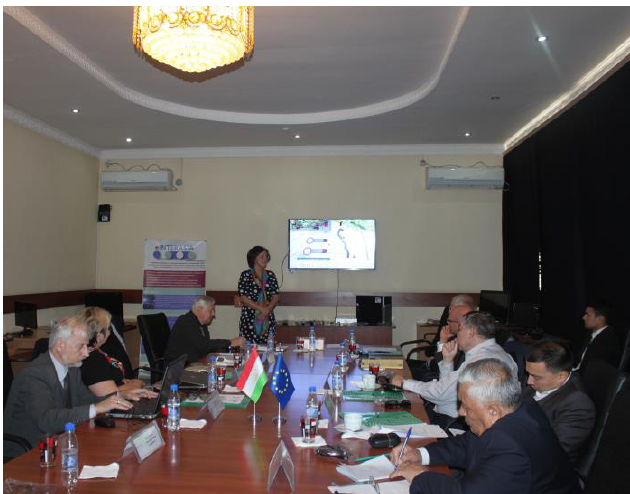
Fig. 8. eINTERASIA meeting related to the opening of the showroom in Dushanbe.